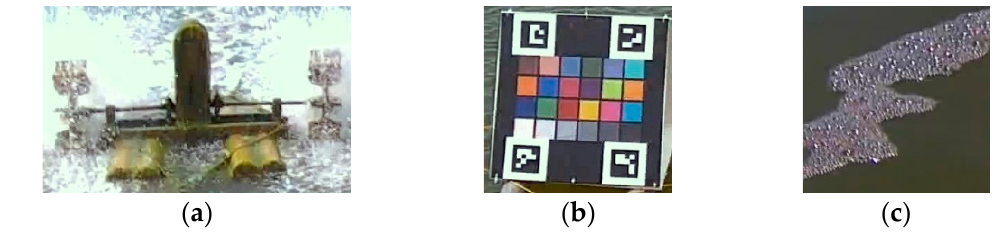
Figure 6. Three classes must be excluded: ( a ) waterwheel, ( b ) checkerboard, and ( c ) foams.